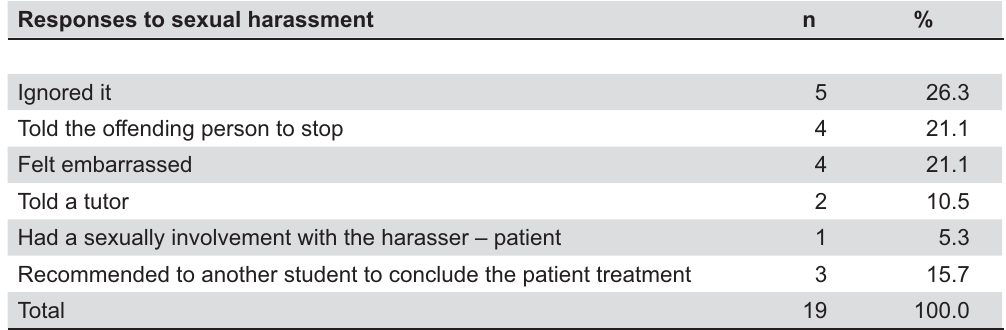
Table 2- Responses of dental students who reported being sexually harassed by a patient in the dental care settings